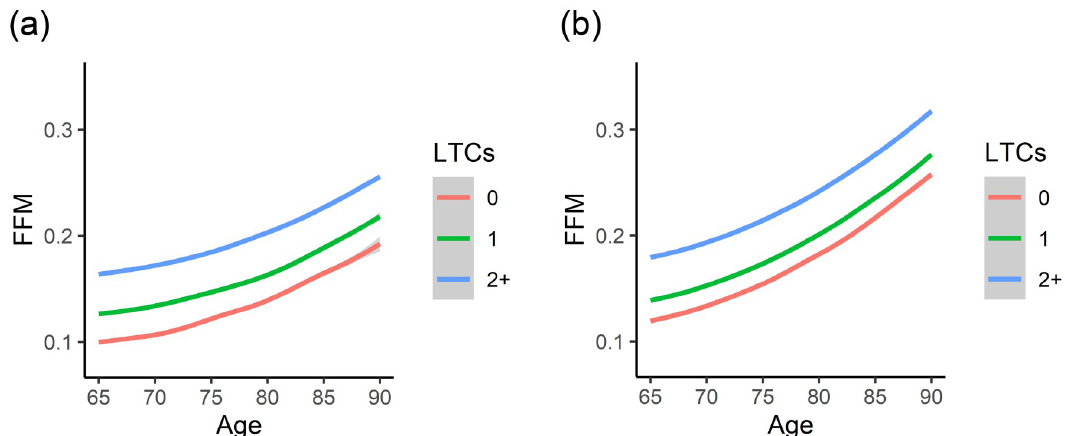
Fig 3. The interaction between the age and FFM. a): The interaction between the age and FFM grouped by LTCs for males. b): The interaction between the age and FFM grouped by LTCs for females. The acceleration of FMM increases for males with one LTC or more; however in females the acceleration of FMM increases when they have two LTCs or